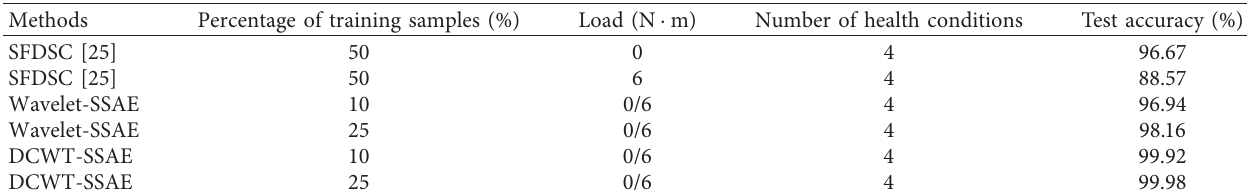
Table 3: Classification comparison of worm gear